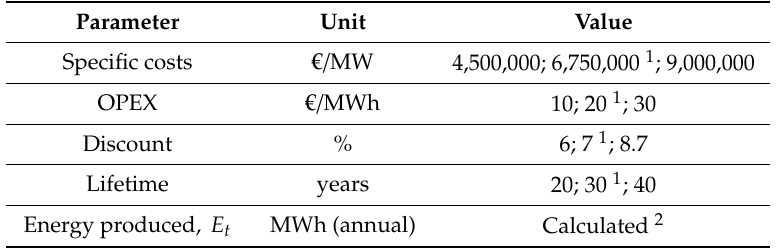
Table 14. Economic parameters used for levelized cost of energy (LCOE)